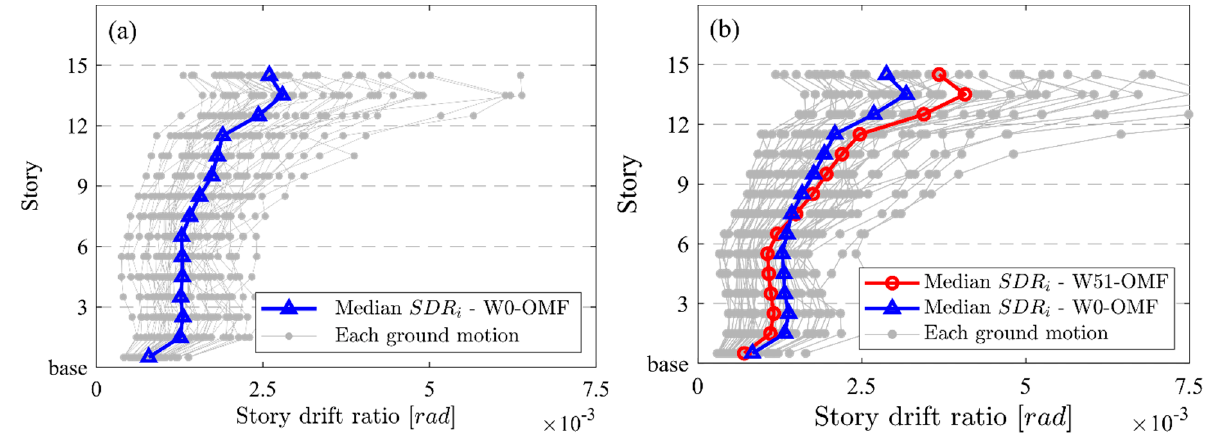
Figure 8. Story drift ratio ( SDR i ) in the elastic response range: ( a ) 15—story W0—OMF; ( b ) 15—story W51—OMF.